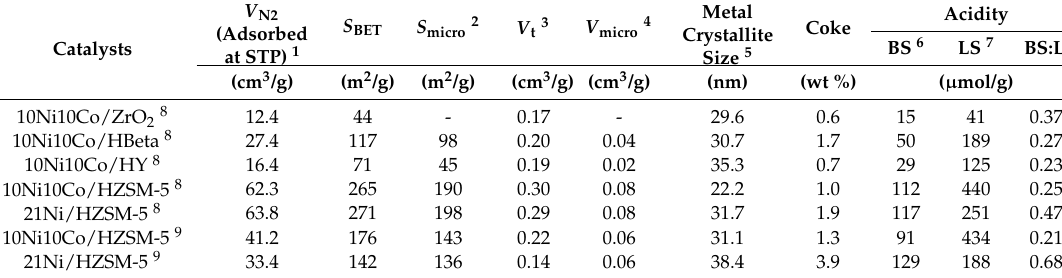
Table 2. Textural and acidic properties of the spent catalysts.